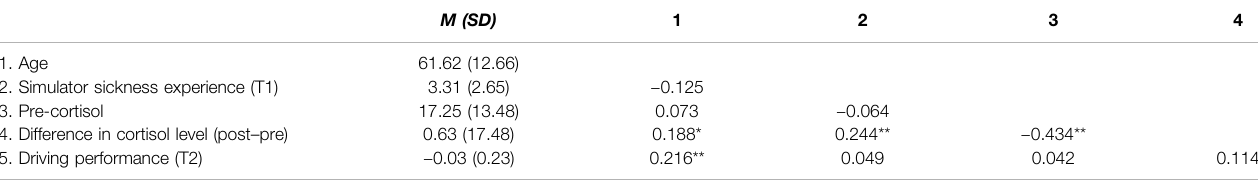
TABLE 1 | Descriptive statistics and bivariate correlations between age, simulator sickness experience, pre-cortisol level a difference in cortisol level (post – pre), and driving performance. M